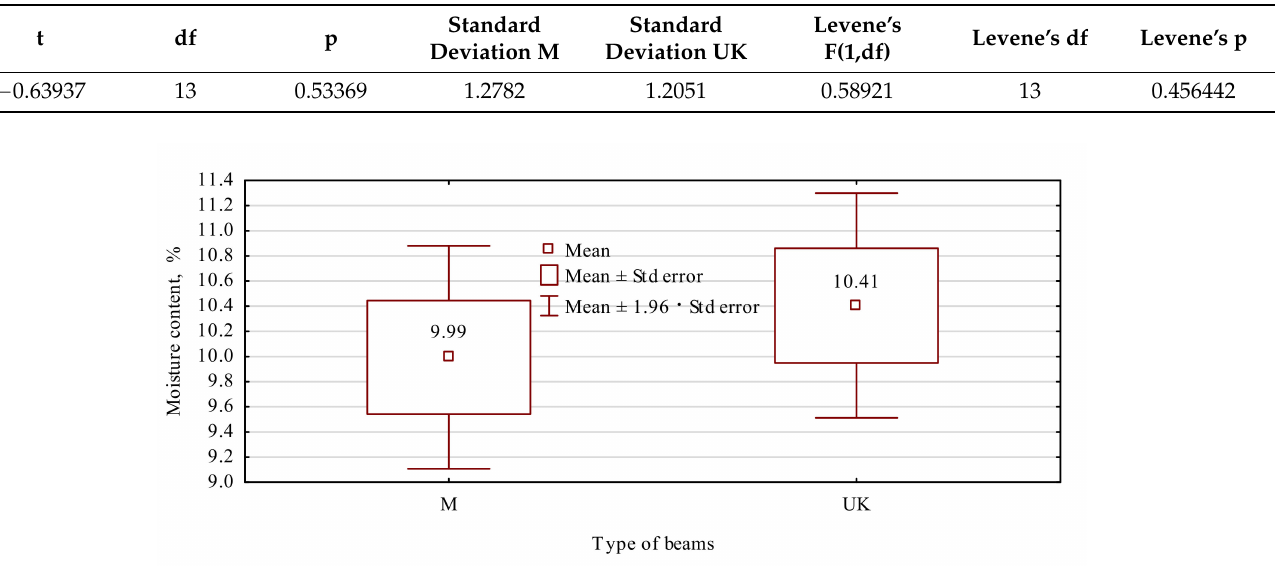
Table 4. Statistical analysis of the moisture content of beams.